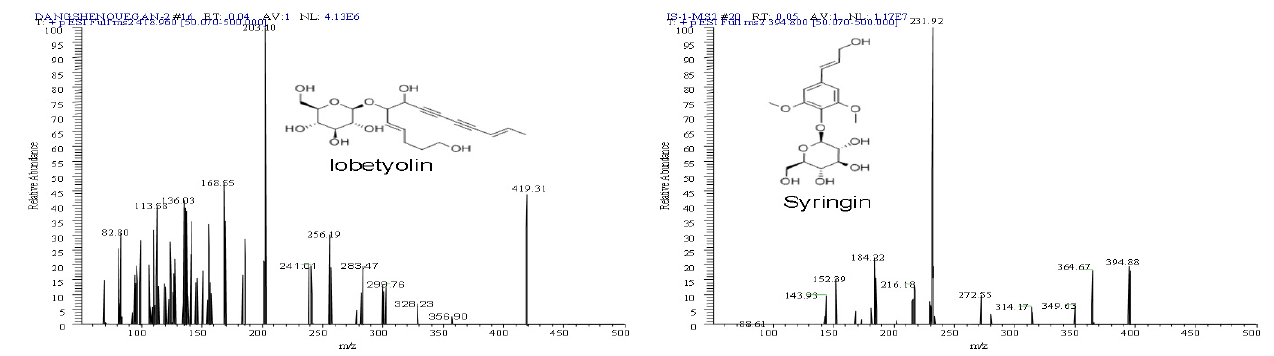
FIGURE 1 - The structures and product ion mass spectra of lobetyolin and